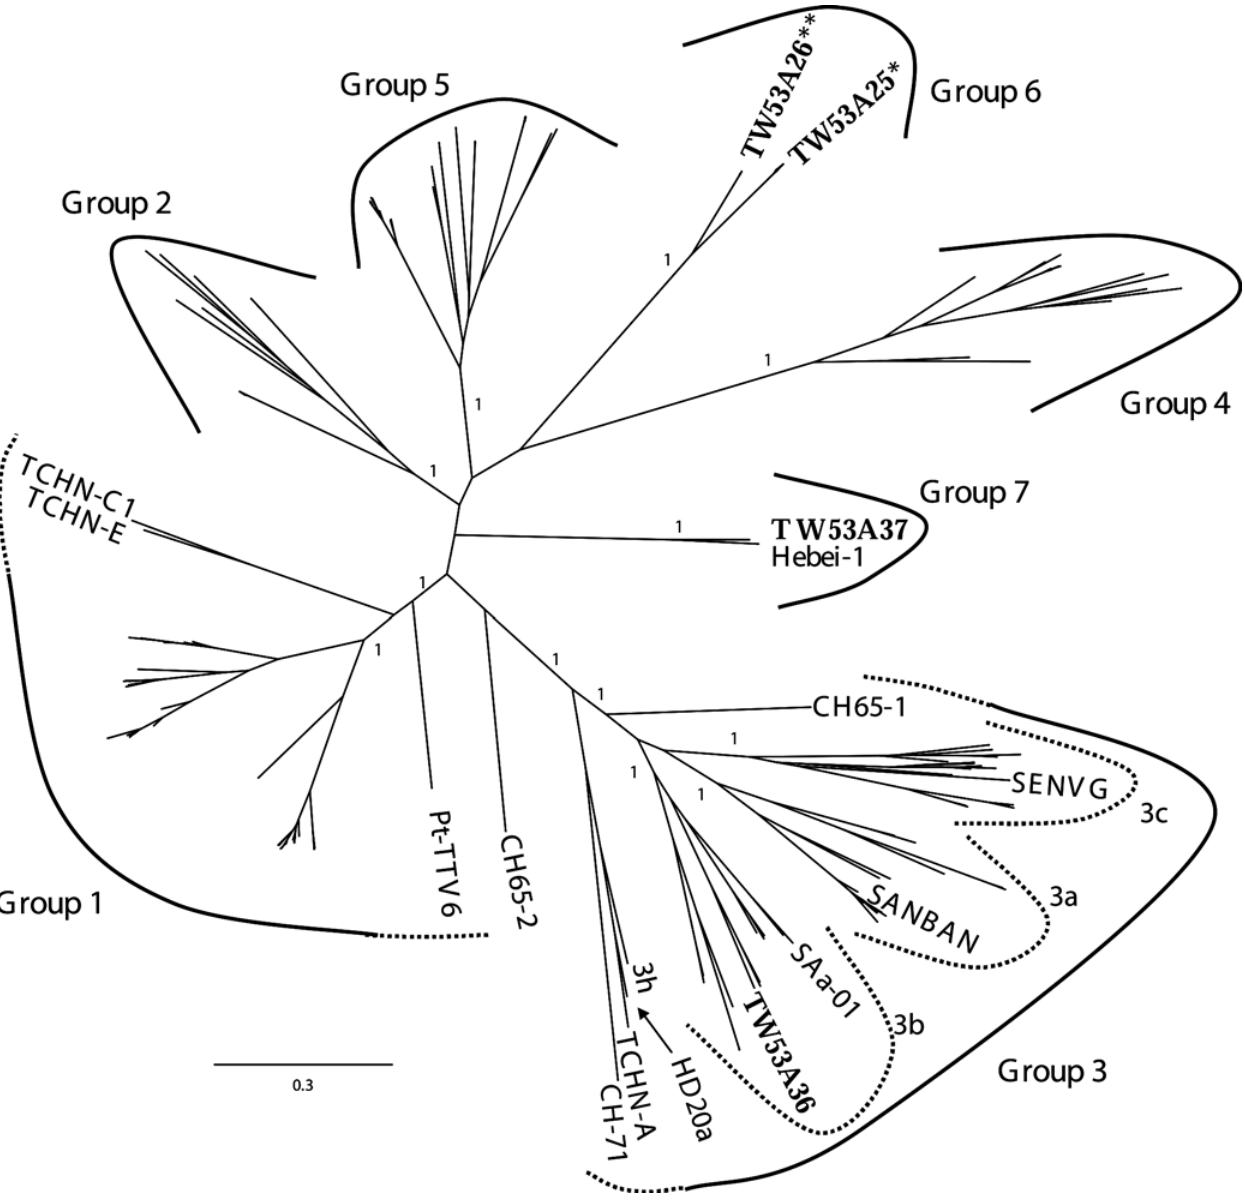
Fig 1. Unrooted Bayesian inferred maximum clade credibility tree of TTV ORF1 well aligned region. Posterior probabilities are labeled at major branches. Branches with a posterior probabilities equal or above 0.95 are considered as strong supported. Isolates from this study are labeled in bold. The scale bar at the left bottom indicates evolutionary distance in unit of substitutions per site per generation. The semicircular symbols indicate seven major TTV phylogenetic groups. The dash lines indicate tentatively classifications. Tentatively classified strains are labeled for reference. The SANBAN, SAa-01, and SENVG are arbitrarily chosen as representative for showing subgroup 3a, 3b, and 3c respectively. See S1 Fig and S1 Appendix for detail taxa list. * Label TW53A25 including 8 isolates (TW53A25, TW53A27, TW53A28, TW53A29, TW53A32, TW53A34, TW53A35, and TW53A39). ** Label TW53A26 including 3 isolates (TW53A26, TW53A30, and